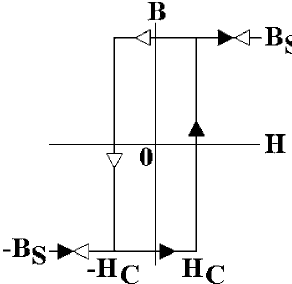
.FIG. 1. Rectangular hysteresis loop: B S is the induction at saturation, H C the coercive